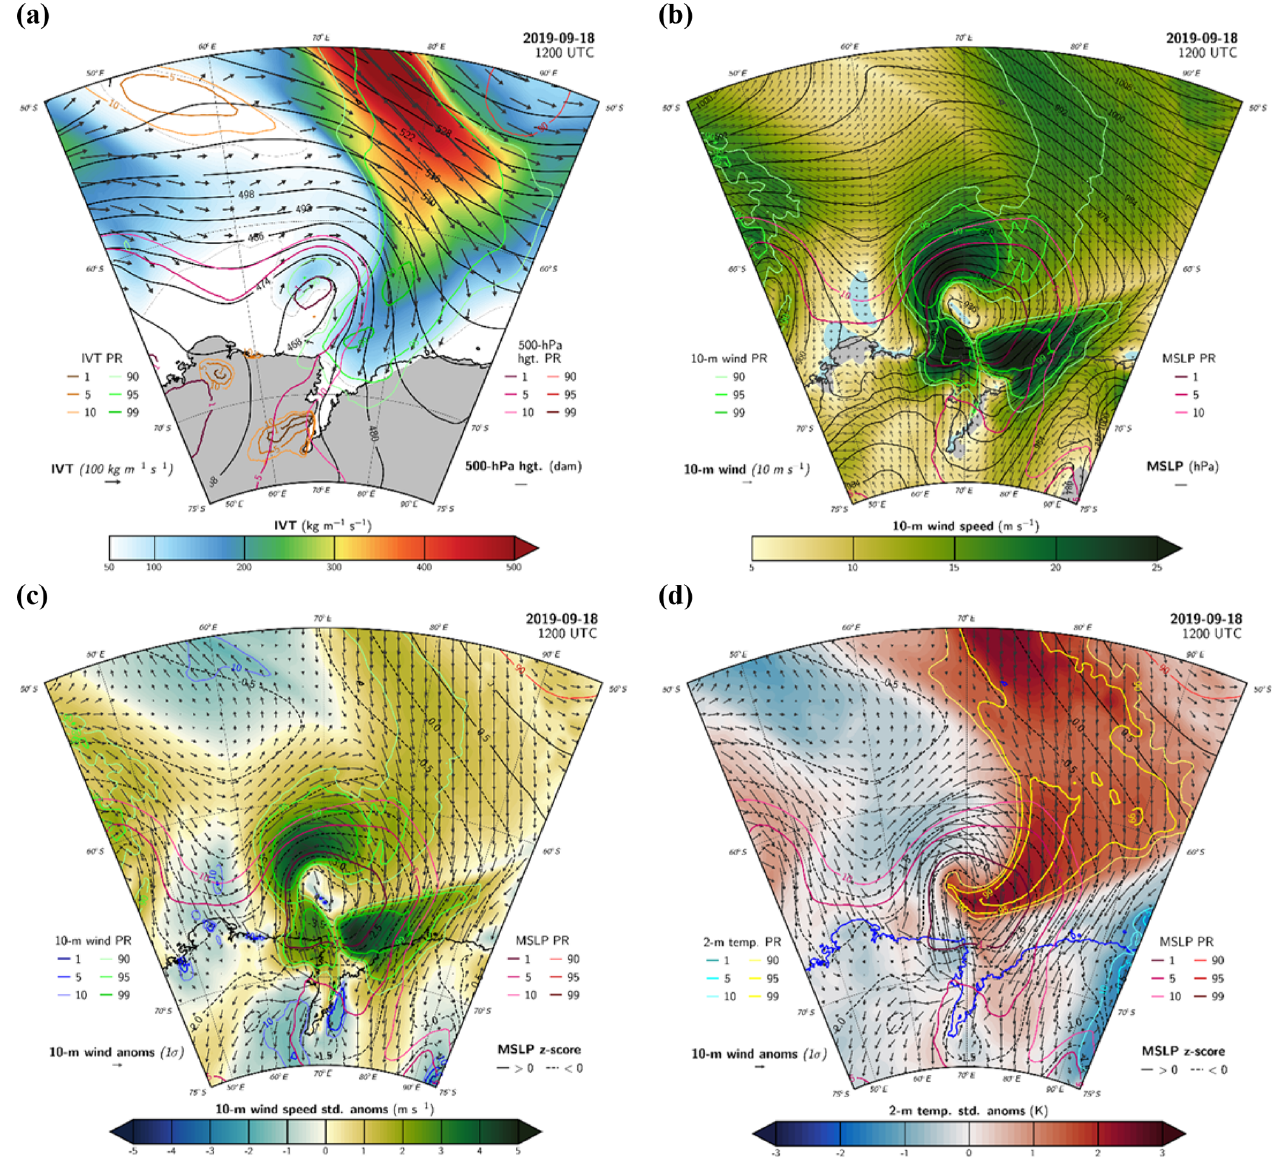
Figure 3. Maps on 18 September 2019 at 12:00UTC of (a) geopotential heights (hgt) shaded by integrated water vapor transport (IVT) at 500hPa in black contours and IVT direction in black vectors; (b) 10m wind speed in colors, with 10m wind direction in black vectors and MSLP in black contours. (c) Standardized 10m wind speed anomalies (wind speed std. anoms) relative to the full September record (1979– 2019); (d) same as (c) but for 2m temperature. Colored contour lines show percentile rank (PR) extremes (1st, 5th and 10th as well as 90th, 95th and 99th percentile ranks) of the corresponding quantities indicated on the plots. On (c) and (d) : vectors show 10m wind anomalies; black contours show positive MSLP anomalies; and dashed black contours show negative MSLP anomalies. Please note that the date format used in this figure is year month day